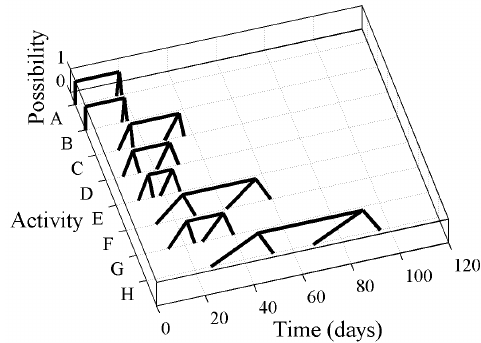
Fig. 11. Fuzzy Gantt Chart-3D with overlap